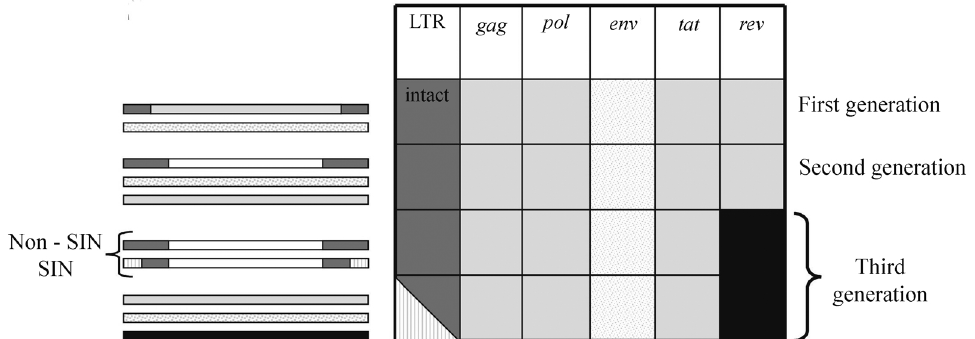
Figure 4 - Schematic diagram of first, second and third generation vectors. Long terminal repeats (LTR, dark gray), structural and accessory genes from packaging constructs (gray) and envelope construct (light gray). Self-inactivating (SIN) vectors are represented by altering the LTR shade (gray and light gray). First generation vectors are derived from only two constructs (transfer and envelope). Second generation vectors present three constructs (transfer, packaging and envelope). Third generation vectors present the rev gene in a different construct (black) with a total of four plasmids: transfer (SIN or non-SIN), packaging ( gag, pol and tat genes only), rev and envelope